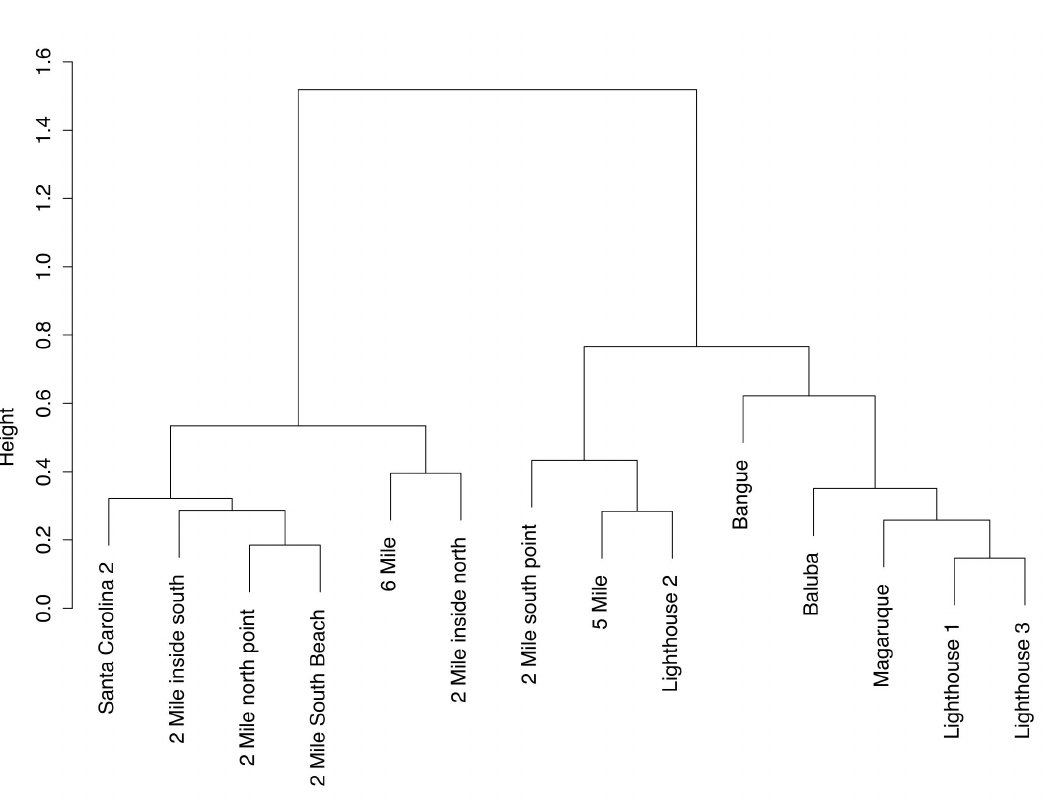
Figure A1. Cluster dendrogram grouping the reefs with regard to benthic cover. Reefs with a higher proportion of hard coral cover are grouped in the left cluster and the rockier reefs in the right